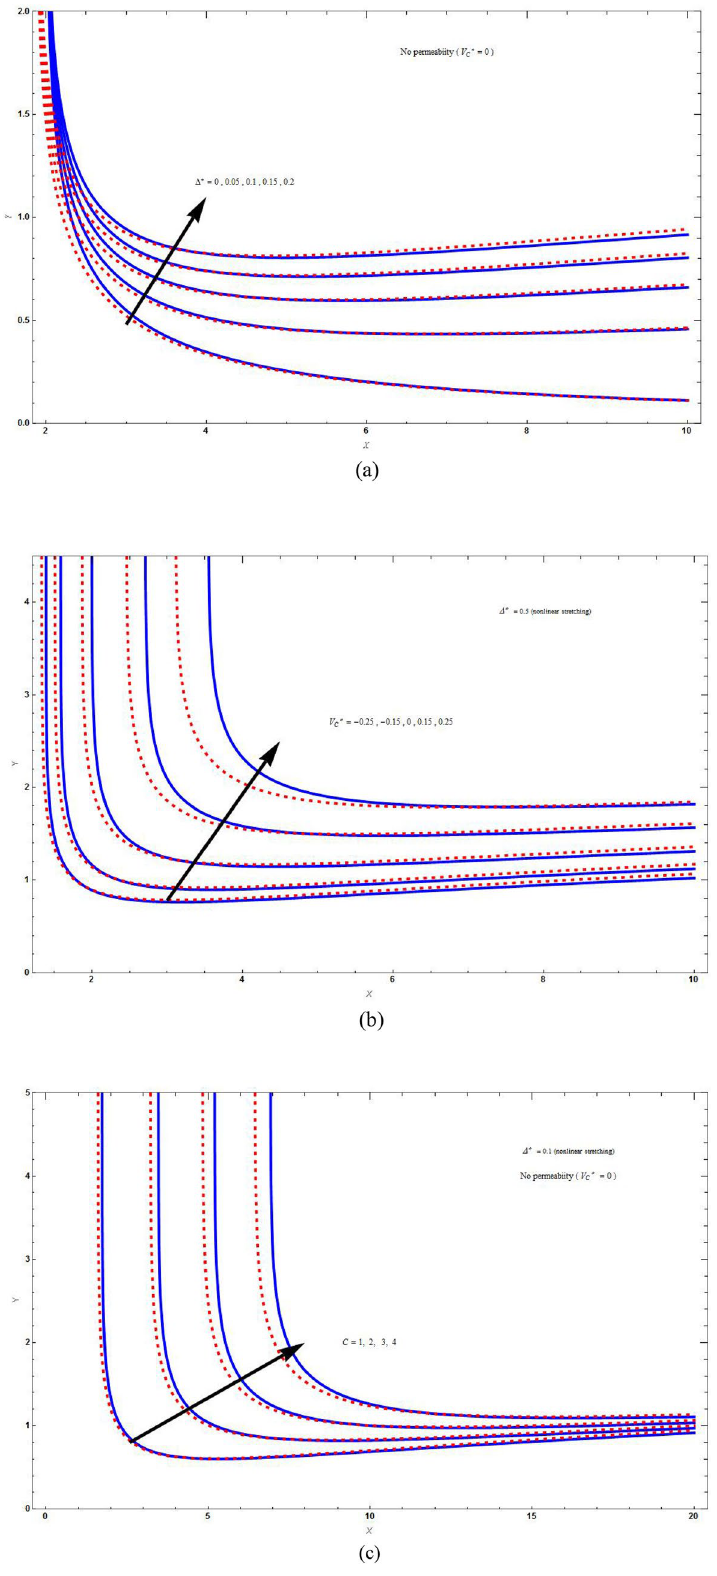
C for varying ( a ) superlinear parameter (� =